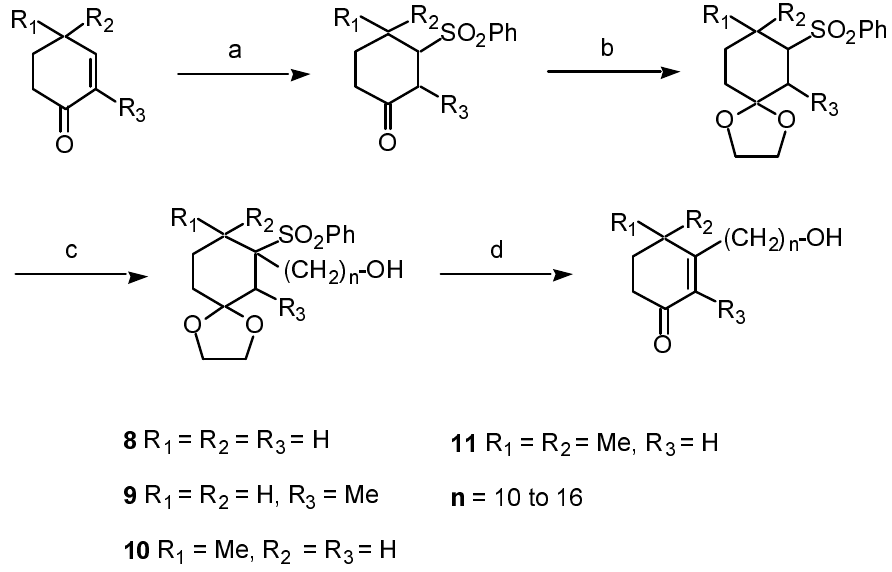
Figure 4. Synthesis of CFA (8), 2m-CFA (9), 4m-CFA (10), and dm-CFA (11). Reagents: (a) PhSO Na, HCl, H O, room temperature (r.t.), 24 hours. (b) HO-(CH 2 2 benzene, reflux, 4 hours. (c) n-BuLi, THF, HMPA, CHPh Br(CH ) OH; THF, -78°C to -20°C, 2 hours. (d) CHCl 2 n